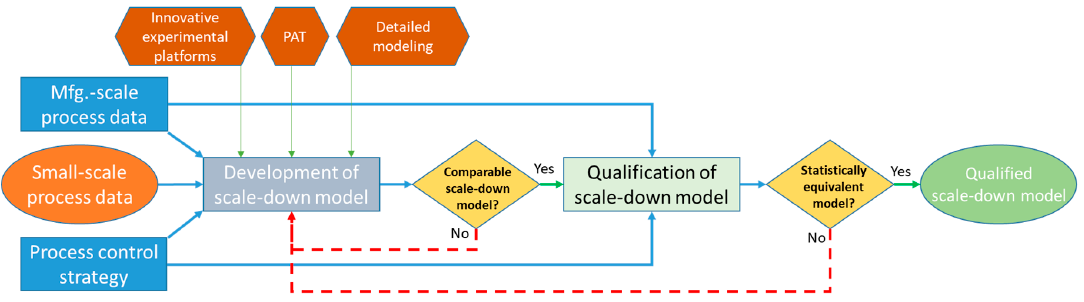
Figure 3. Scale-down modeling workflow supported by innovative solutions.